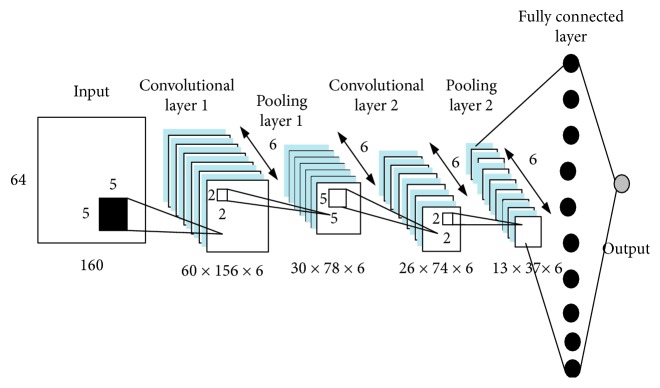
Structure of the CNN proposed by Ma et al. [34].